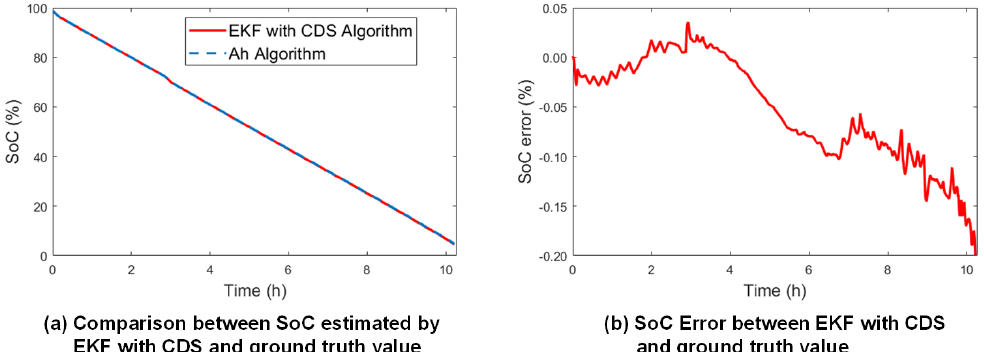
Figure 10. Comparison between SoC estimated by EKF with CDS algorithm and the ground truth (SoC calculated by coulomb counting method): ( a ) Comparison between SoC estimated by EKF with CDS and the ground truth; ( b ) SoC error between EKF with CDS and the ground